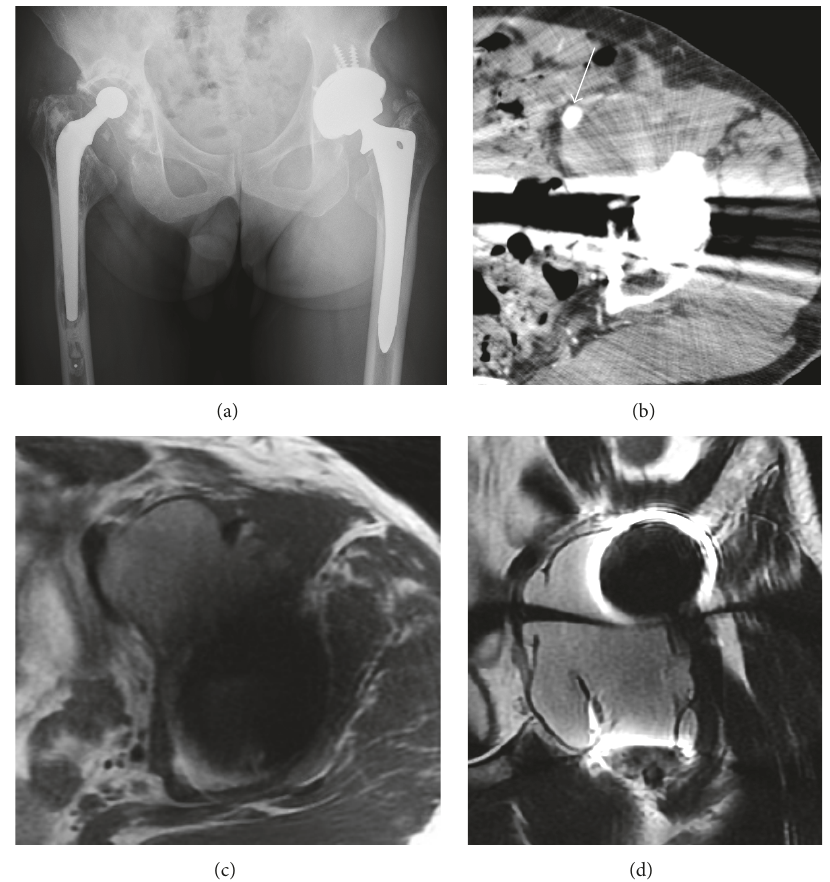
Figure 1: Plain radiographic, contrast-enhanced computed tomographic, and magnetic resonance images of the hip. Anteroposterior view on plain radiography shows no abnormal findings around the left hip (a). Axial view on contrast-enhanced computed tomography reveals a cystic lesion at the anterior aspect of the left hip compressing the left femoral vessels (white arrow, (b)). Magnetic resonance imaging reveals a cystic lesion extending from the anterior aspect of the left hip to the intrapelvic region. The mass has iso-high intensity on a T1-weighted axial image (c) and high intensity on a T2-weighted coronal image